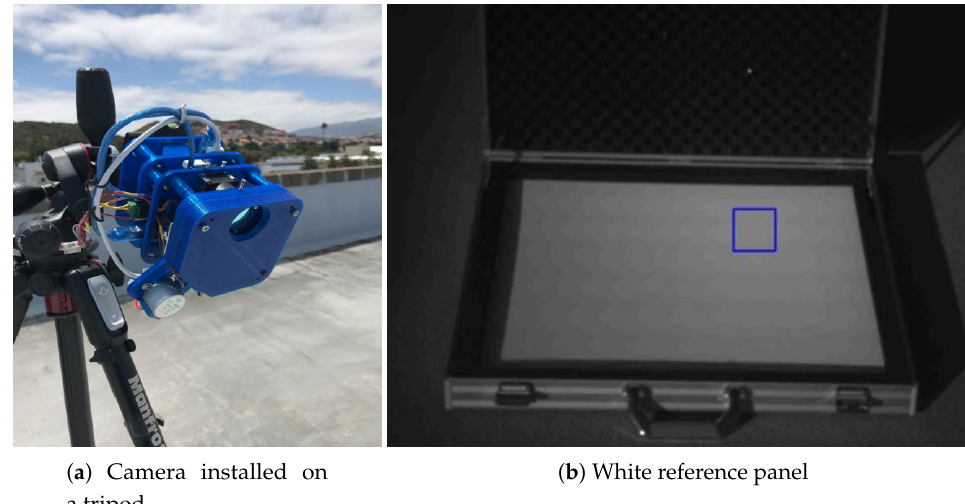
Figure 7. Calibration